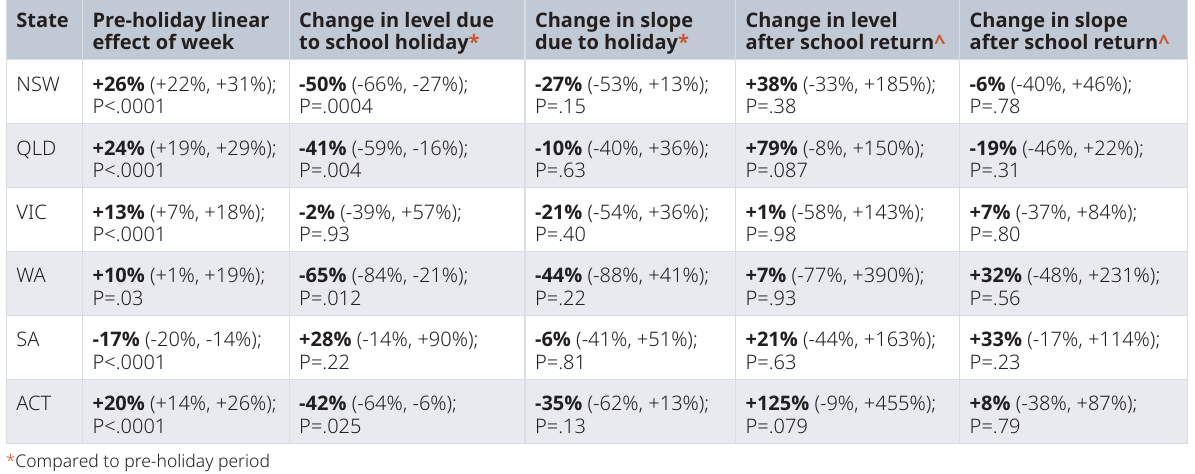
Table 1. Estimates (95% CI) from segmented regression models of weekly influenza counts.